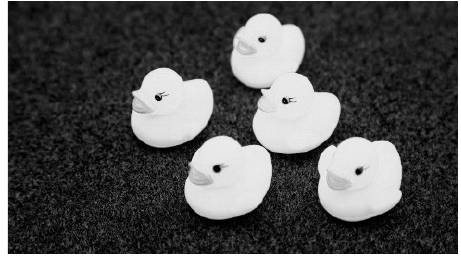
Figure 3. Grayscale